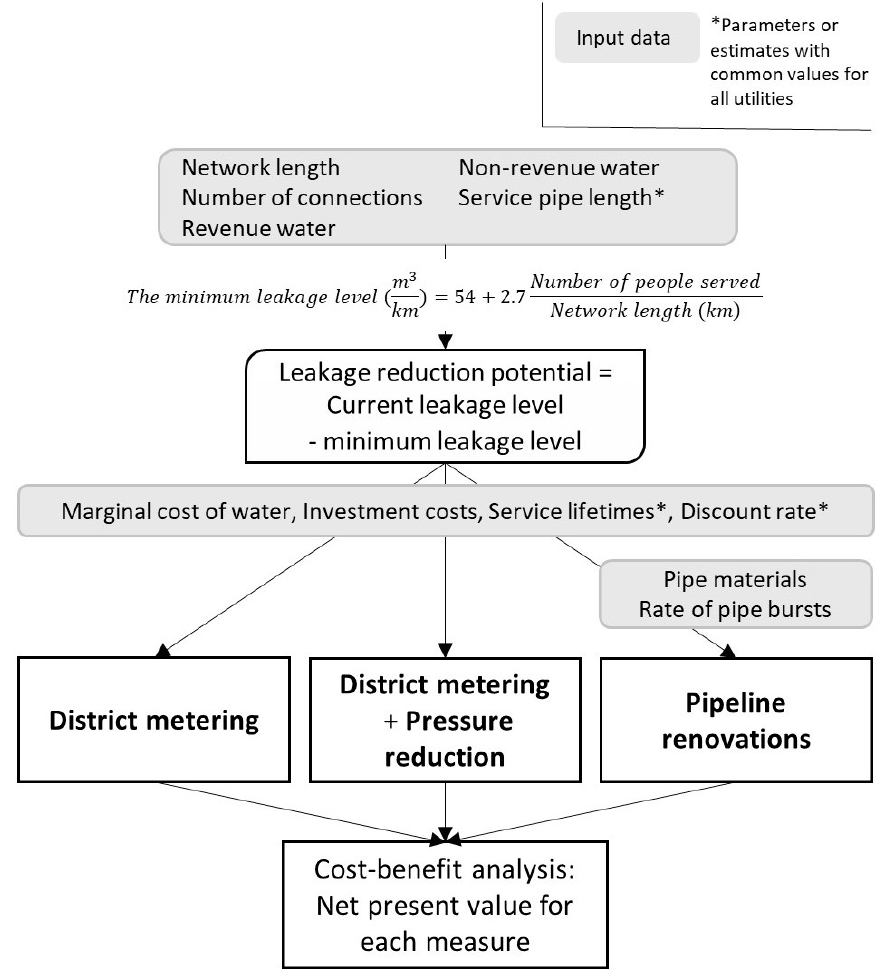
Figure 1. Steps of the analysis for calculating the net present value of three leakage reduction measures: (1) district metering areas, (2) district metering areas with pressure reduction, and (3) renovations. Water Supply in